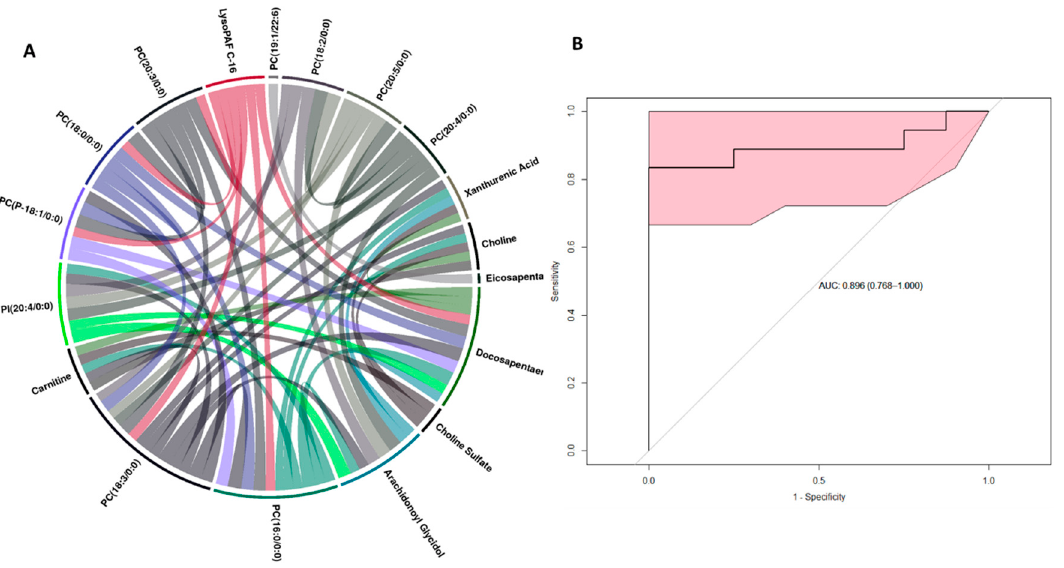
Figure 3. Metabolite correlates of radiation response in NHP liver. Panel A. Circos plot visualization of Spearman correlation values between 18 top cut-off point p-value < 1 × 10 − 30 . Panel B. The ROC curve with a six-metabolite panel predictive of post-irradiation survival in NHPs liver. The classification algorithm showed sensitivity = 0.833, specificity= 0.875, AUC: 0.869, and a predictive accuracy of 0.846.